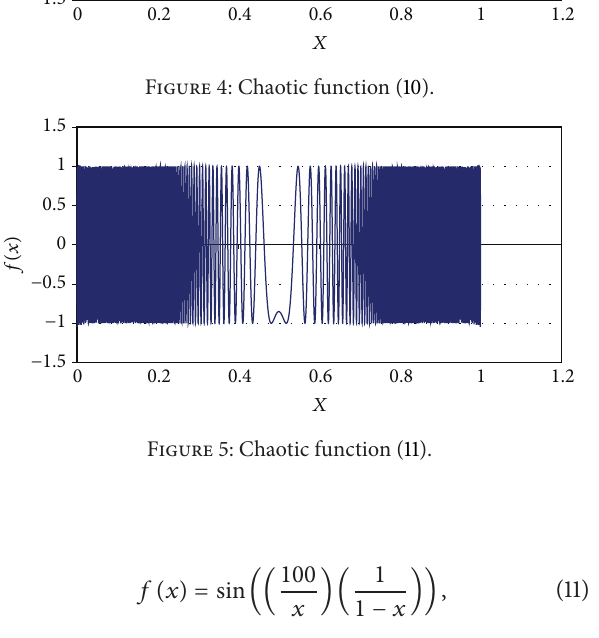
Figure 8: Graphic of average energy and dRMSD (proinsulin